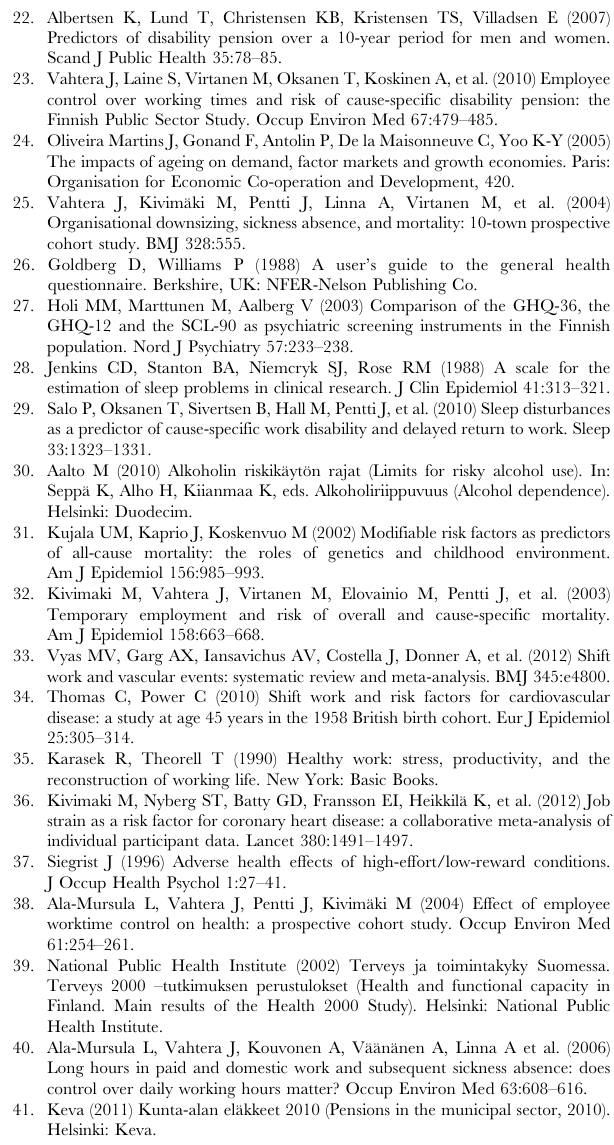
File S1 Supporting tables. Table S1. Association between baseline characteristics and extended employment at . 6